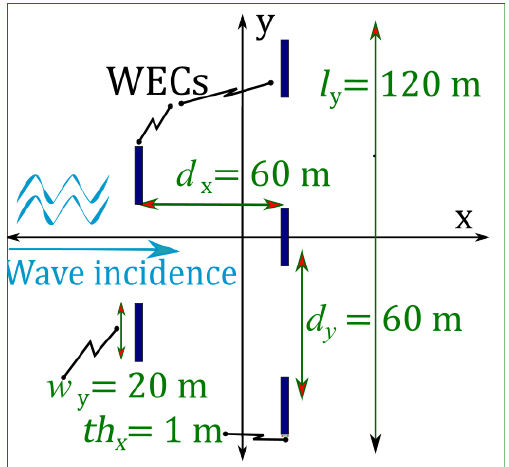
Figure 11. Plan view of the array layout for five pitching OSWECS. The incident wave propagates from the